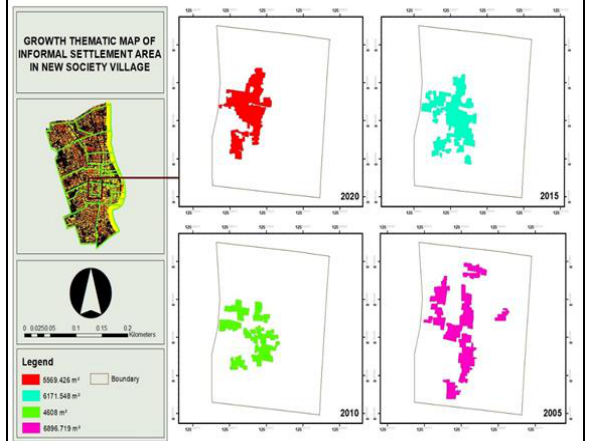
Figure 12. Thematic Map of Brgy. New Society Village